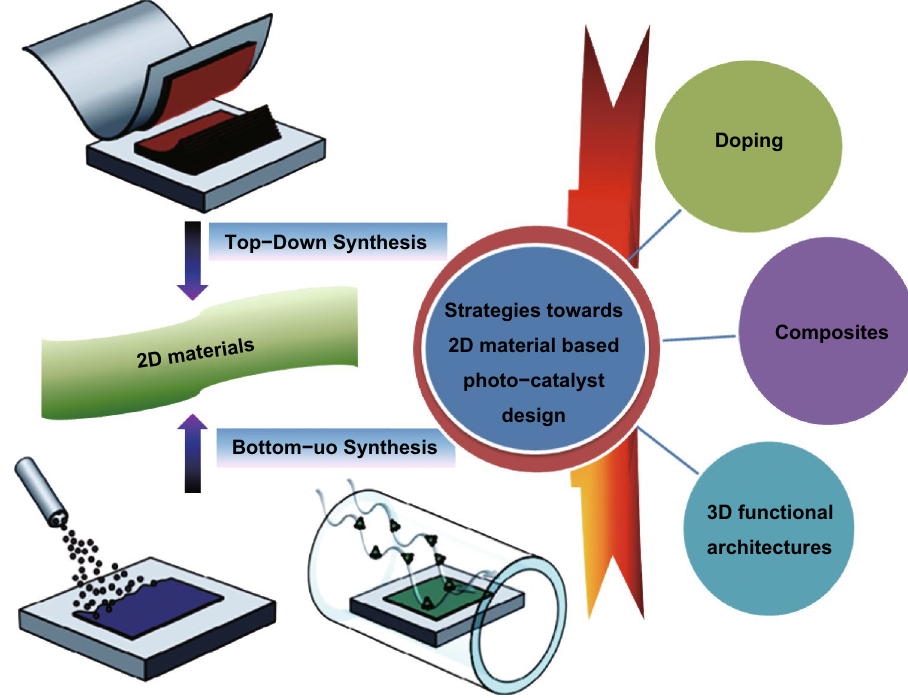
Fig. 2 Scheme of 2DMs synthesis and strategies toward 2DM‑based photo‑catalyst